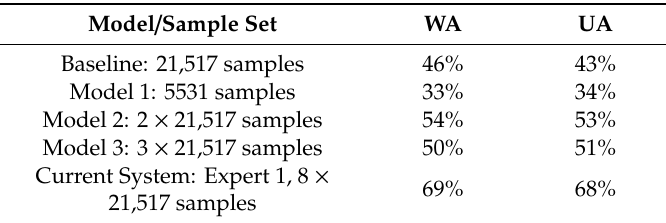
Table 2. Test results of expert